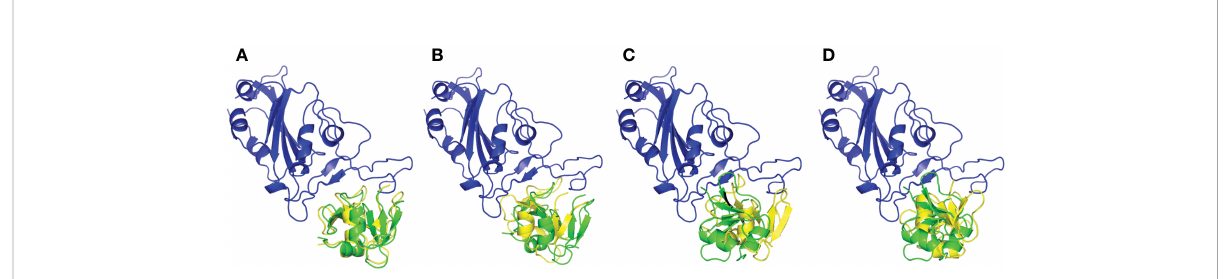
FIGURE 3 Aligned structures obtained from different docking servers for the docked h BD-2 dimeric forms at the SARS-CoV-2 RBD interface. Docked h BD-2 dimers generated from ClusPro (green cartoon) and ZDOCK (yellow cartoon) were aligned at the binding interface of the